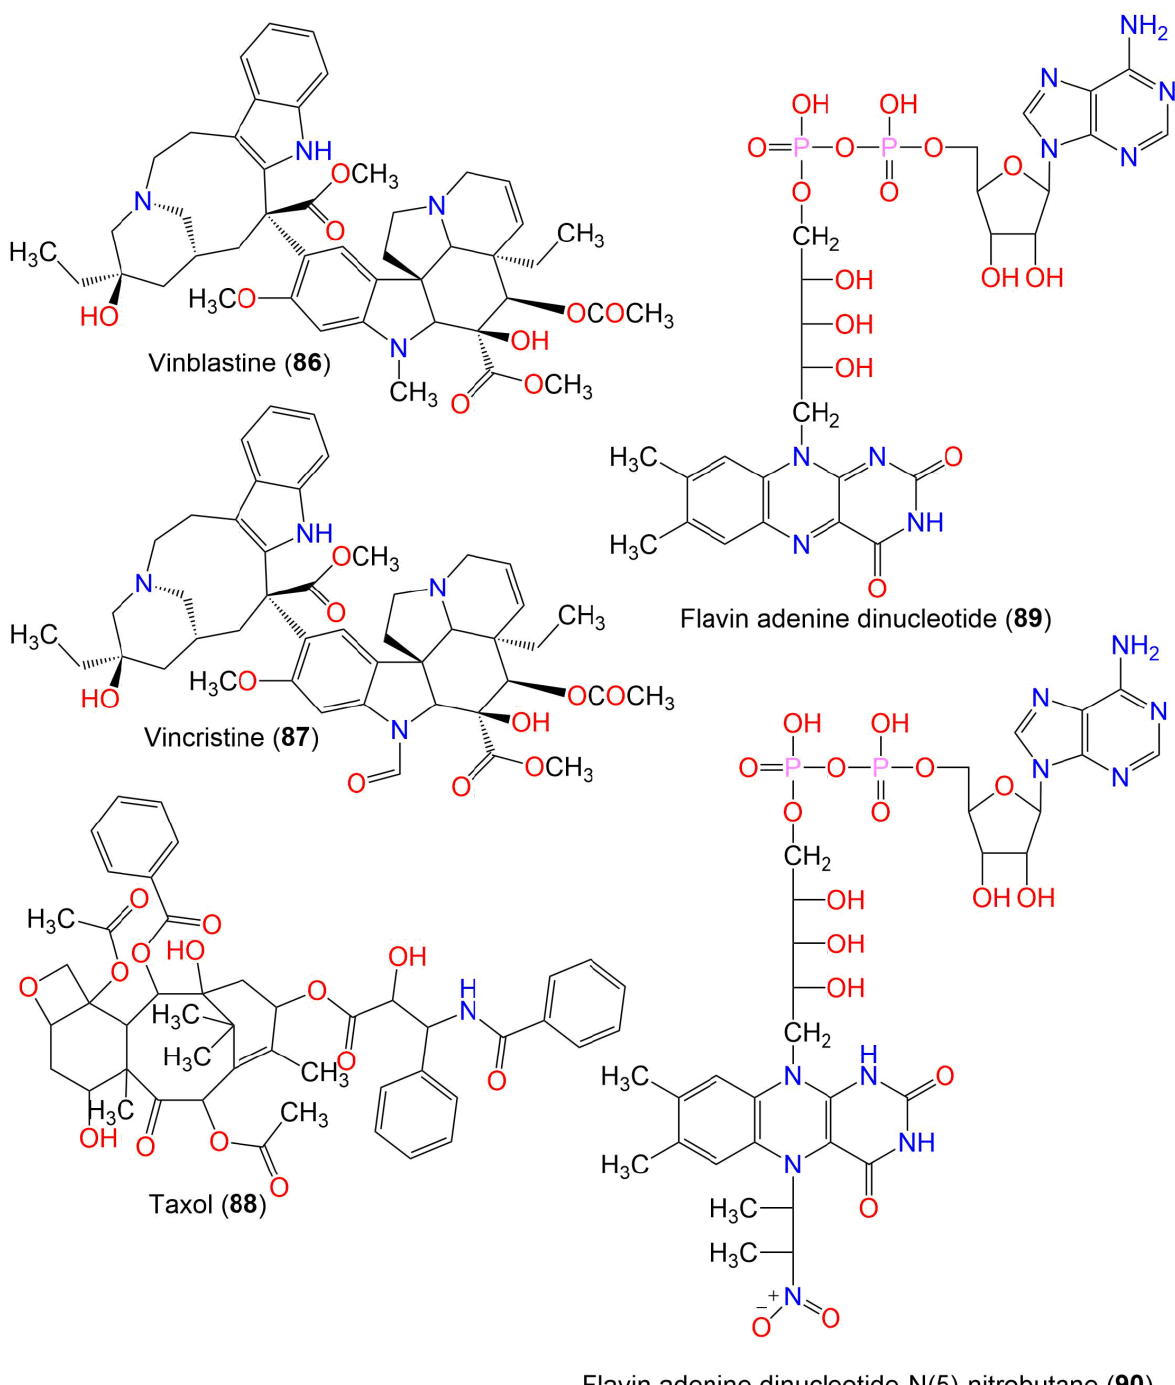
Figure 8. Structures of alkaloids ( 86 – 90 ) isolated from F. oxysporum .